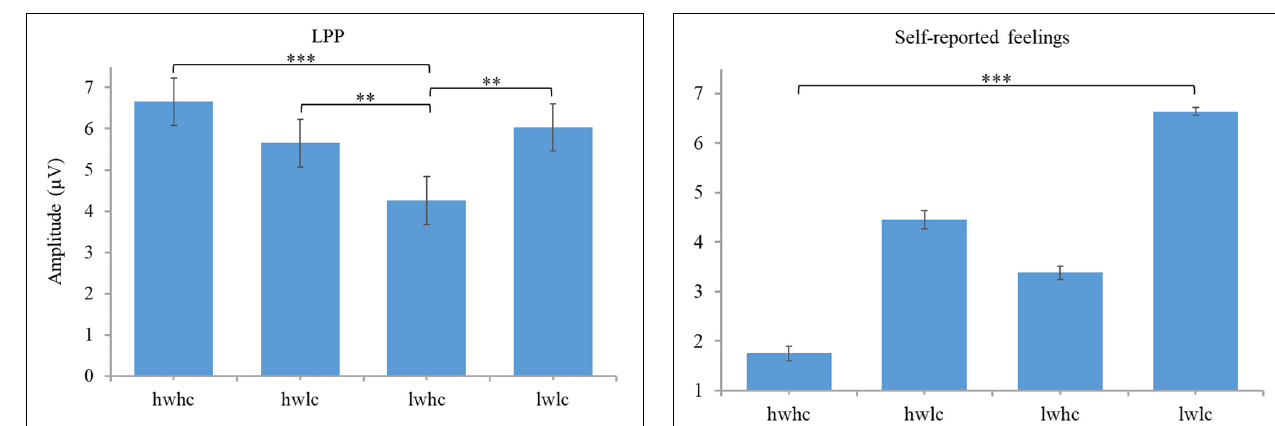
FIGURE 7 | Descriptive statistics and contrasts for self-reported feelings (hw, high warmth; lw, low warmth; hc, high competence; lc, low competence; ∗∗∗ p ≤ 0.001).